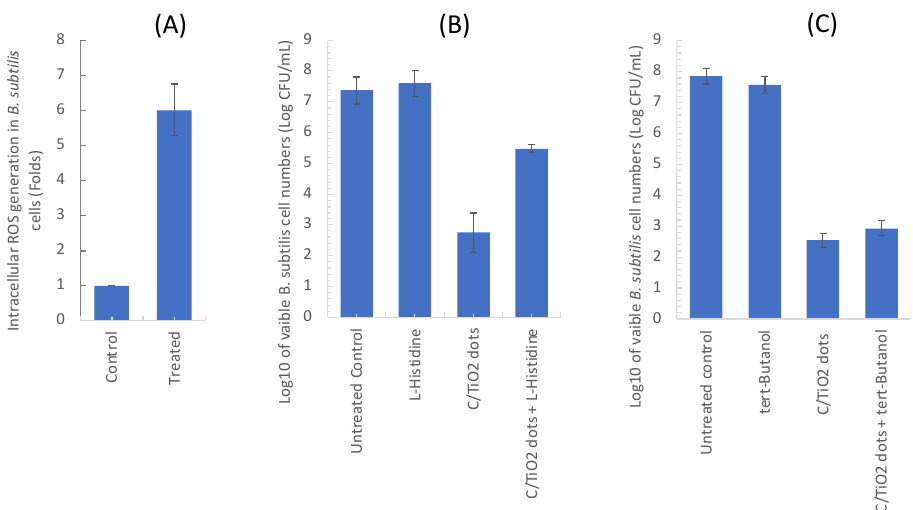
Figure 4. ( A ) The fold increase in intracellular ROS generation; and ( B ) the viable cell number change in B. subtilis after the cells were treated with C/TiO 2 hybrid dots in the presence and absence of ROS scavenger L-histidine, and ( C ) in the absence and presence of ROS scavenger t -butanol, along with those of untreated control cells. Treatment: 0.1 mg/mL PEI&PEG-C/TiO 2 -Dots with visible light illumination for 2 h. Scavenger concentration: 60 mM.